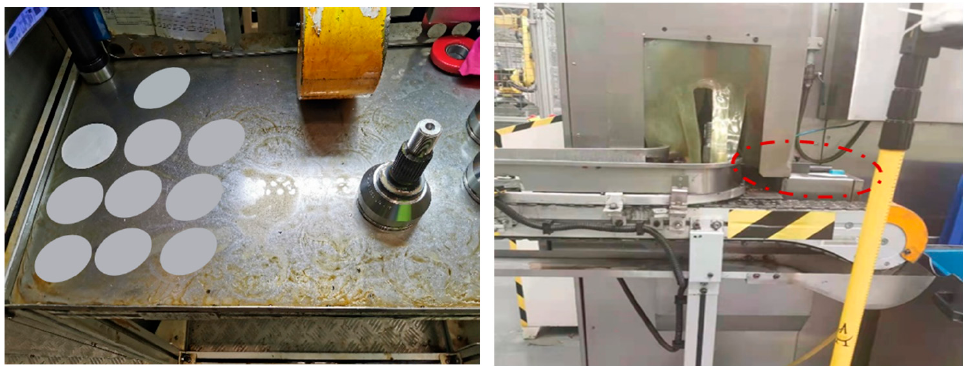
Figure 3. Schematic diagram of measuring points. Table 1. On ‐ site measurement results of the three experiments.